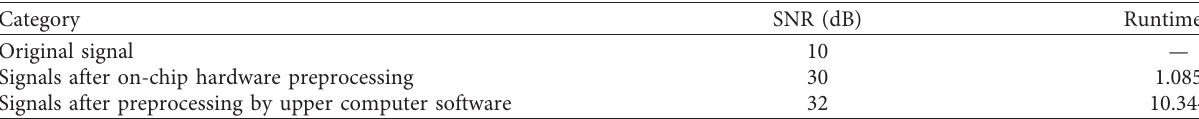
Table 5: Results of signal preprocessing.